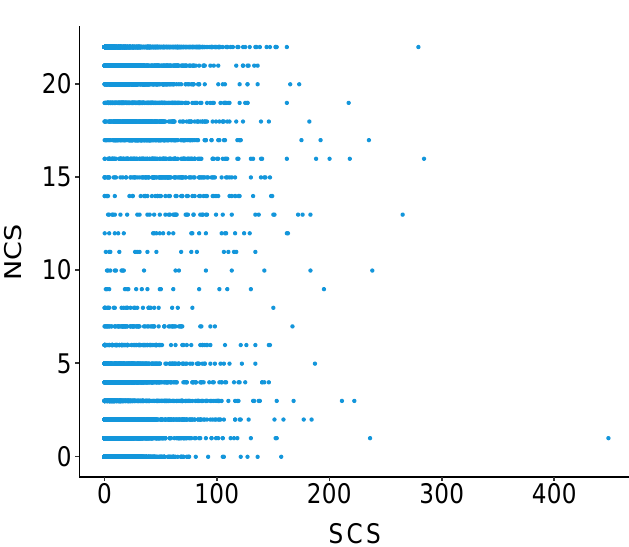
Figure A1. The NCS versus the SCS in TCGA tumours from 33 different cancer